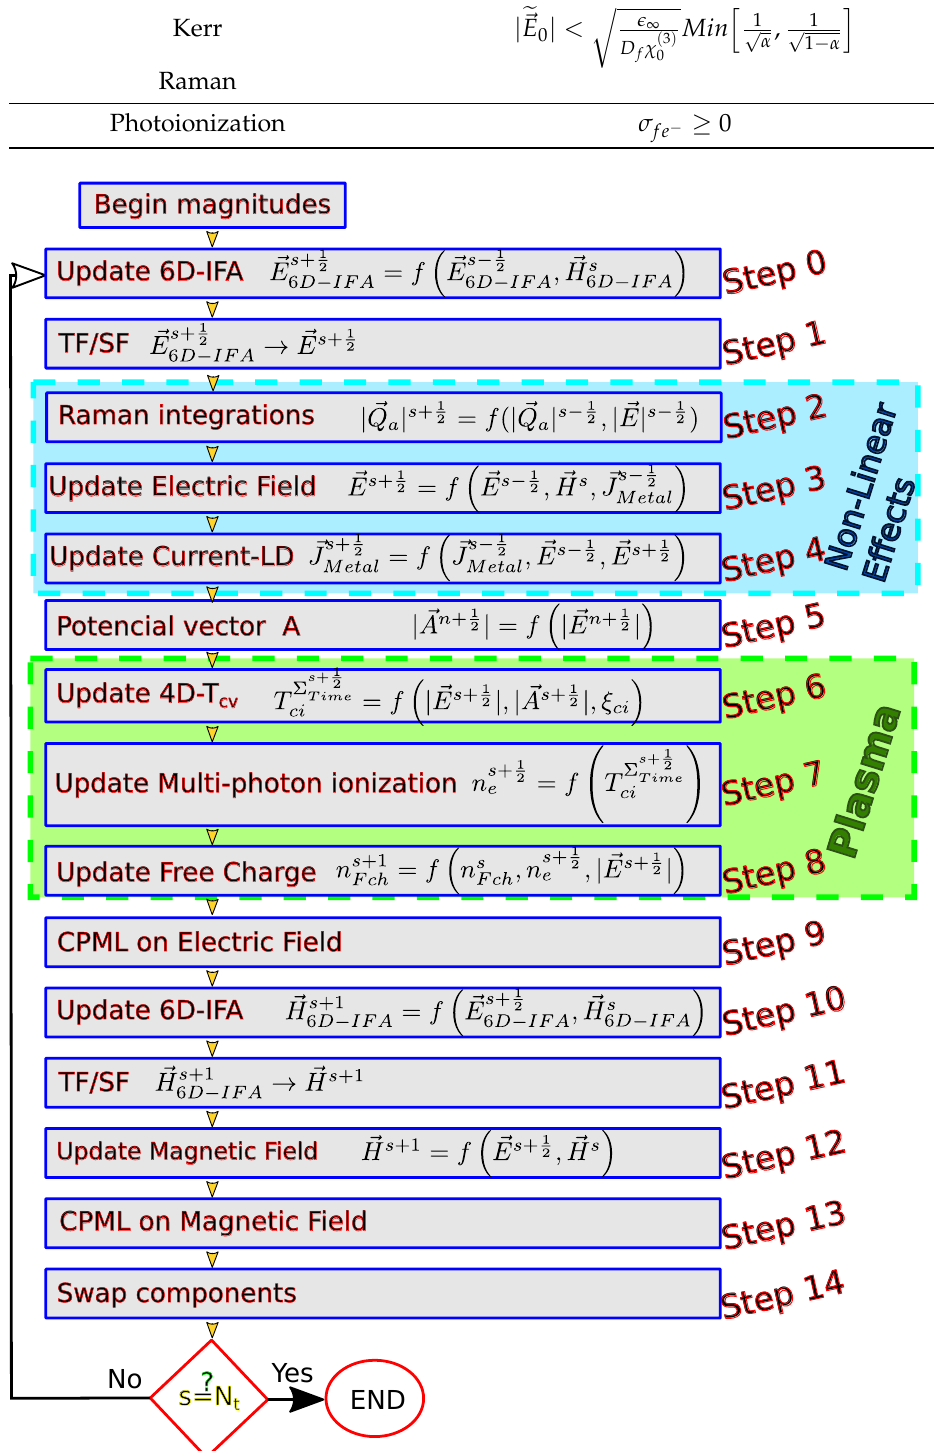
Figure 2. Global flow chart of the proposed GVADE-FDTD